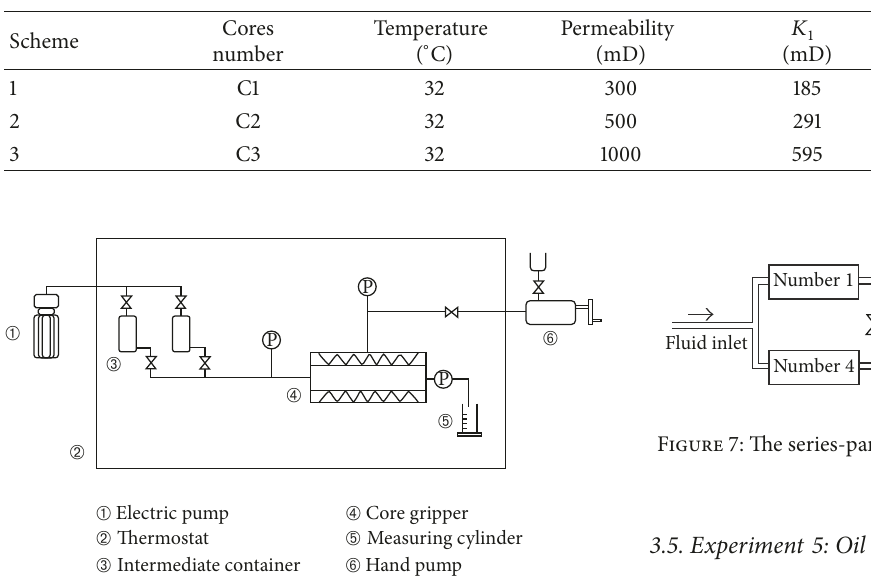
gelling time is and the lower the gel strength is. On the time is and the greater the gel strength is.